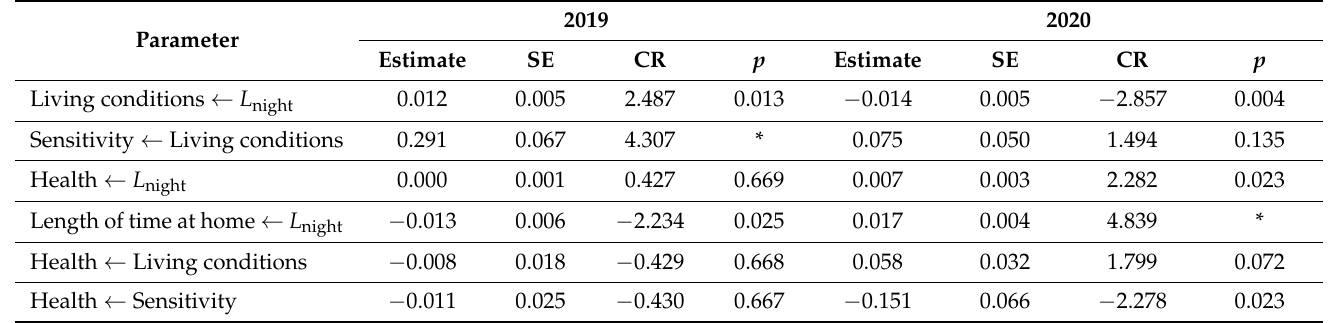
Table 14. Parameter estimates of the structural equation model for insomnia with length of time at home. Parameter